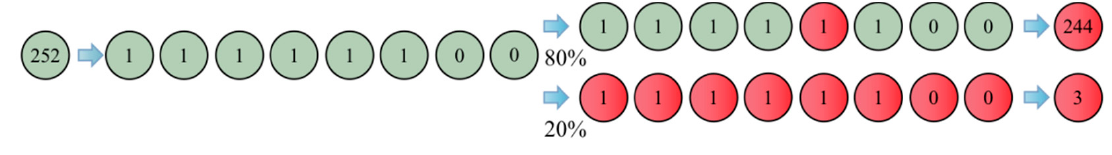
Figure 2. Schematic diagram of PRV.